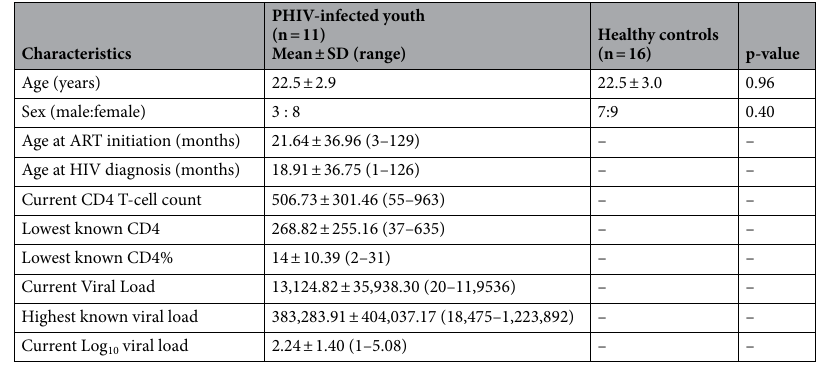
Table 1. Demographic and clinical characteristics. Demographic and clinical characteristics of PHIV-infected youths and healthy controls. p-value shown for group differences assessed with independent samples